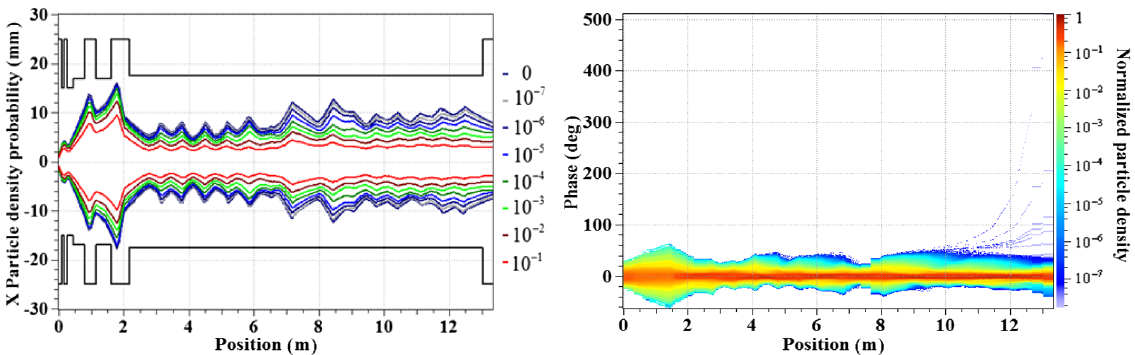
FIG. 23. The error analysis results of the 50% input emittance deviation case: transverse particle density level in the x plane (left) and longitudinal power density